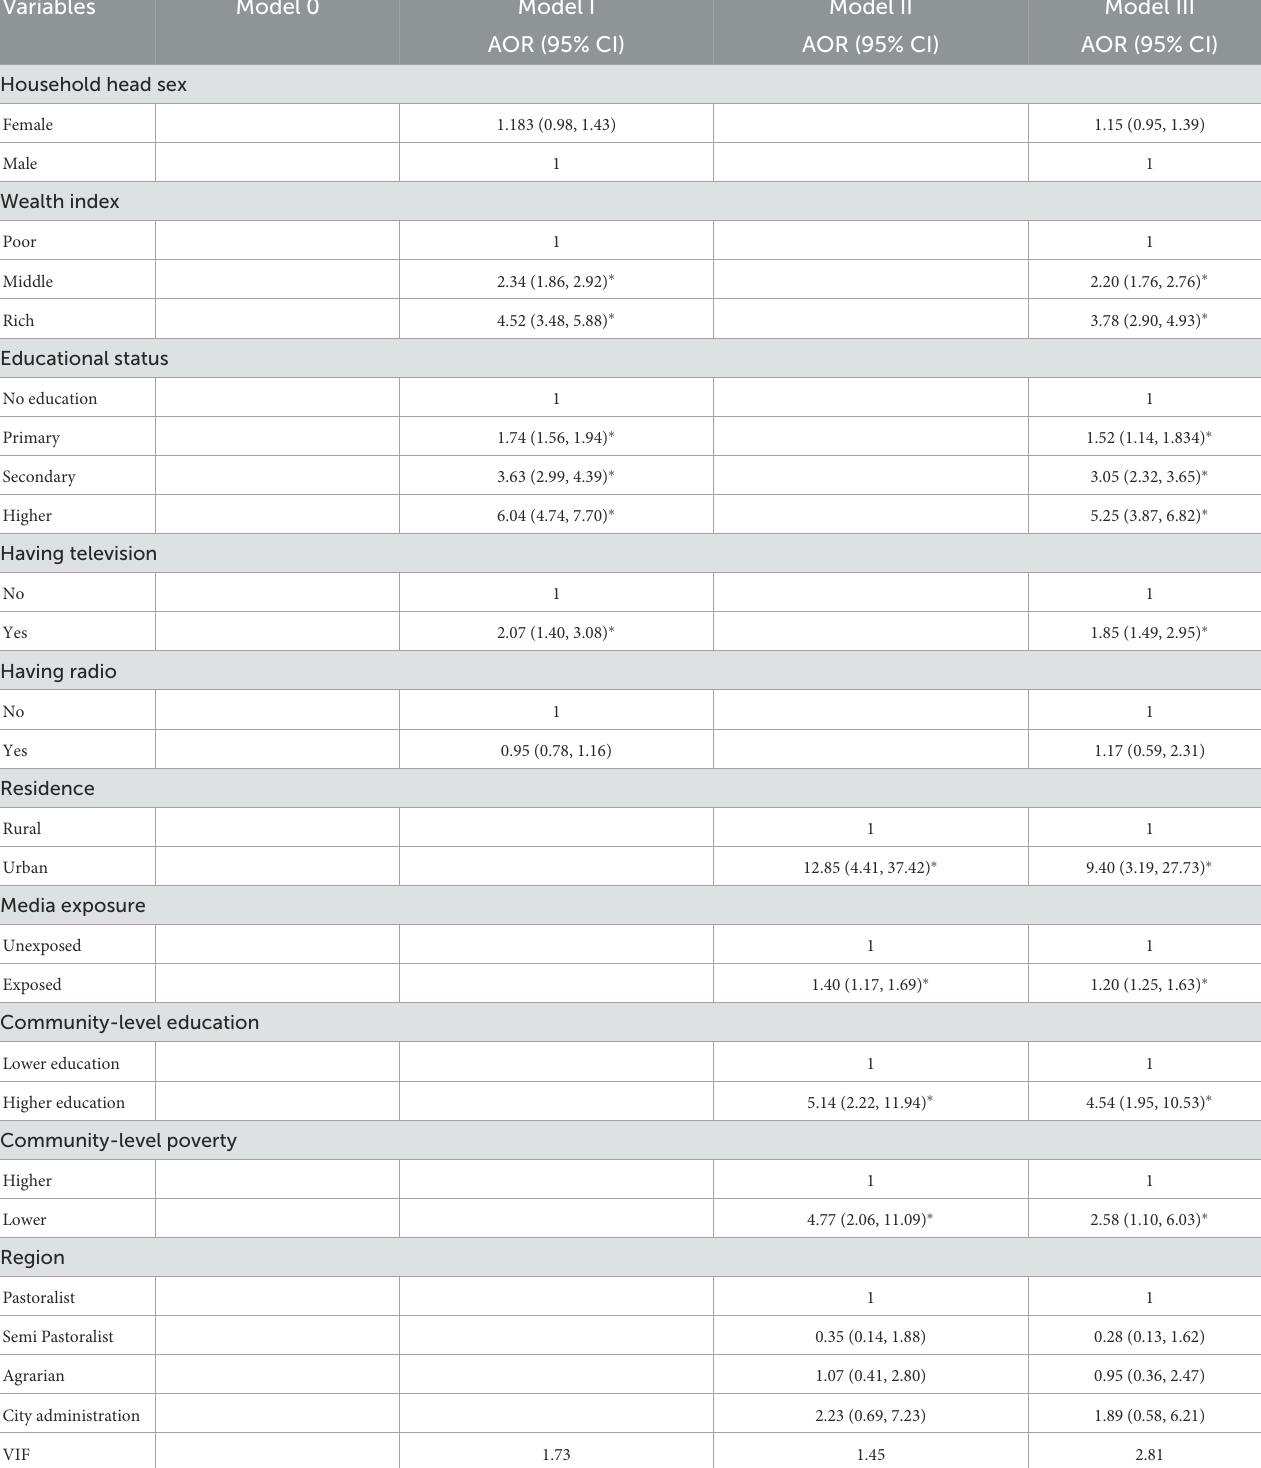
TABLE 3 Multilevel regression analysis improved water source predictors variables in Ethiopia, EMDHS